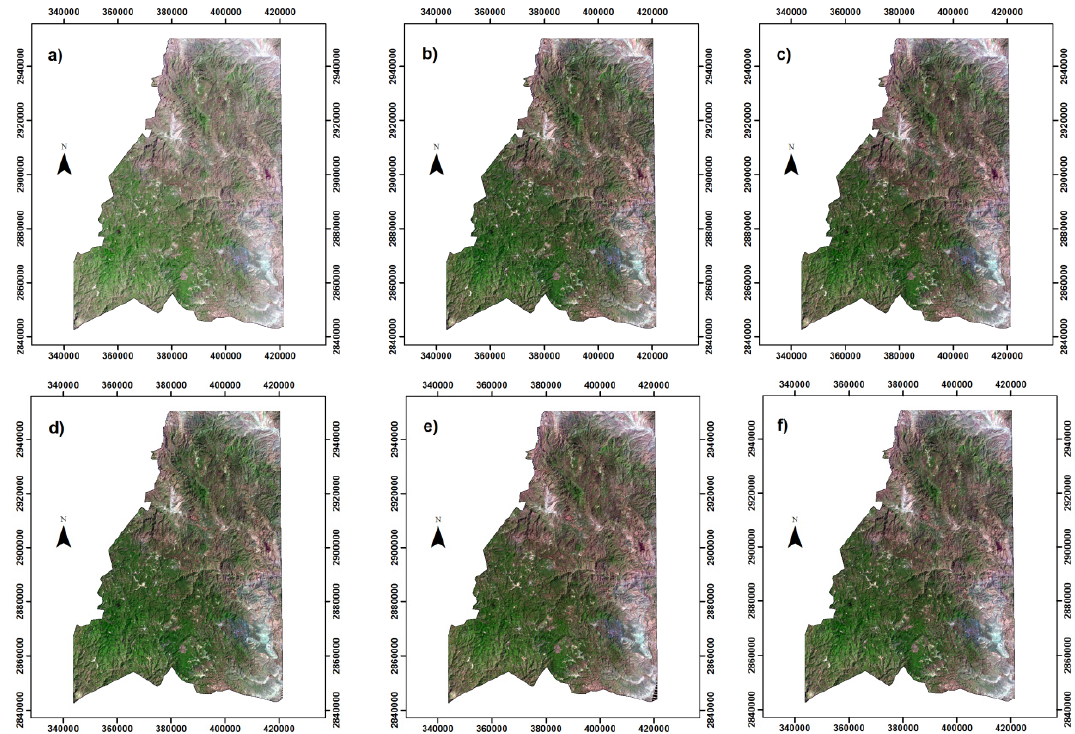
Figure 3. Comparison of the application of the different radiometric correction algorithms: ( a ) original image in DNs (multiband composition 5, 4 and 3); ( b ) ATCOR2; ( c ) COST; ( d ) FLAASH; ( e ) 6S; and ( f ) ToA.